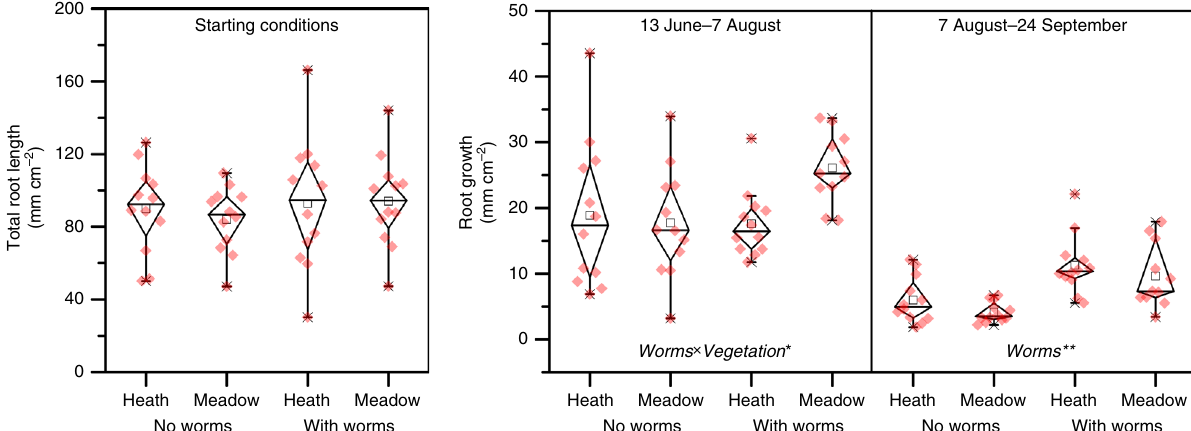
Fig. 5 Belowground plant growth response to earthworm additions. Boxplot showing the fi ne root length at the onset of the experiment before the earthworm addition, and the fi ne root growth after earthworm addition in heath and meadow vegetation (mesocosm with labeled and unlabeled litter are pooled together). Periods when growth was measured are shown at the top. Diamond box indicate the 25%- and 75%-percentile (whiskers indicate the 99% percentile) and black rectangle show the median value. Also shown are all individual measurements (red diamonds). Treatment effects are written at the base of the panels and the level of signi fi cance indicated with *( P < 0.05) and **( P < 0.01). Source data are provided as a Source Data fi